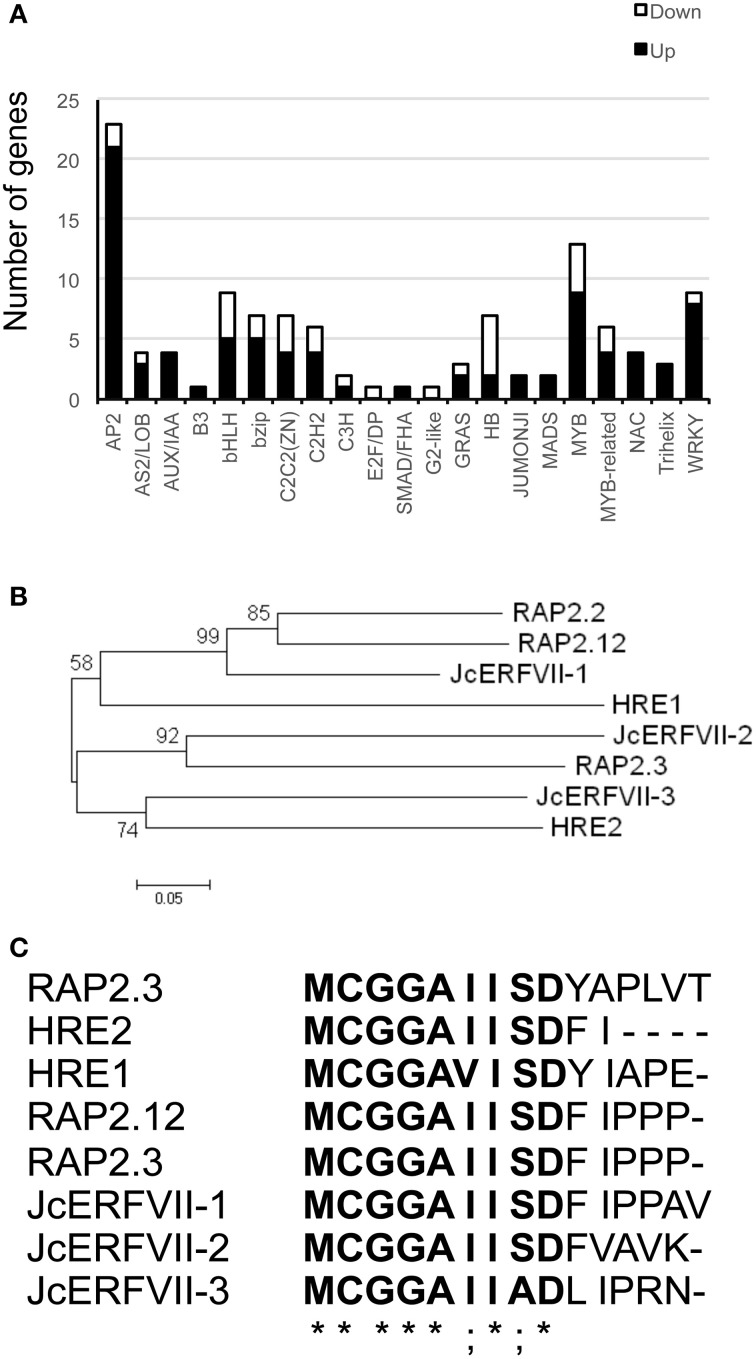
The group-VII ERFs of Jatropha. (A) Graphical representation of waterlogging-regulated transcription factors based on their assigned protein families. “Up” and “Down” represent up-regulation and down-regulation in this analysis. (B) Phylogenetic tree of group-VII ERF proteins. The full-length protein sequences were analyzed with a Neighbor-joining method. Numbers above branches represent the bootstrapped value from 1000 replicates. (C) Multiple sequence analysis of N-terminal sequences of group-VII ERFs. Bold letters indicate a conserved motif at the N-terminus initiated with Met1-Cys2, as identified by multiple sequence alignment. Asterisks and semi-colons indicate identical and conserved substitution, respectively.